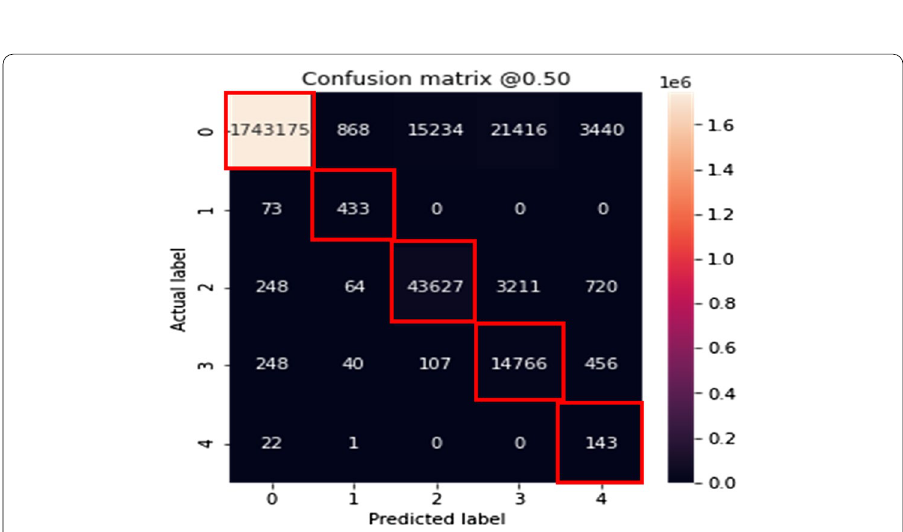
Fig. 8 Confusion Matrix of the proposed model